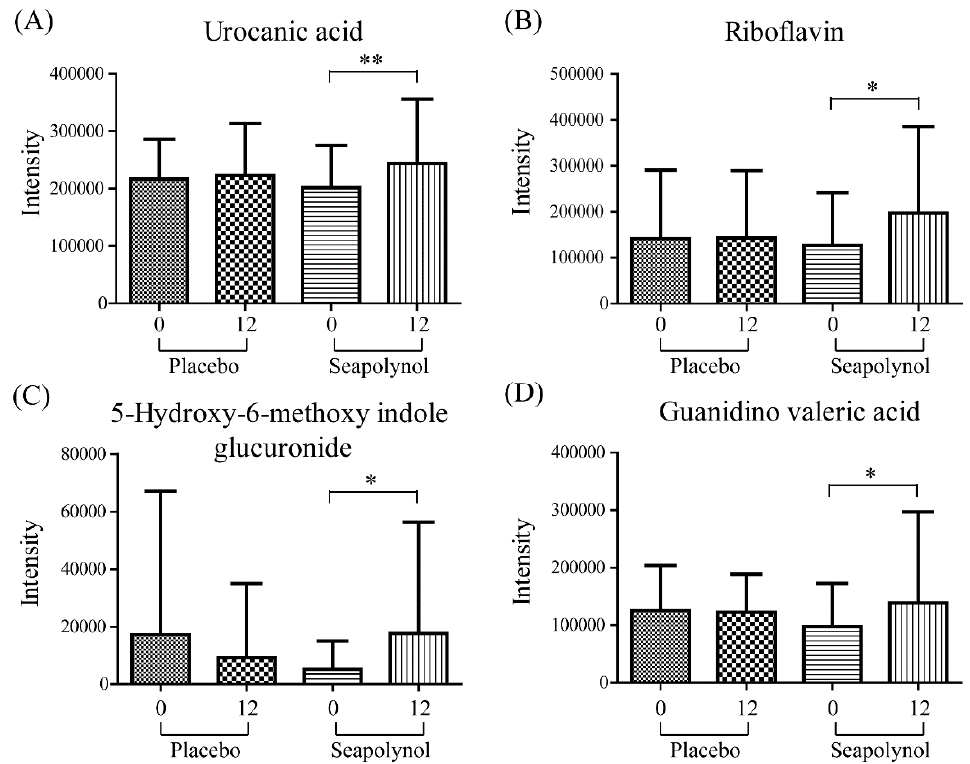
Figure 3. Changes in the levels of the identified metabolites. The levels of ( A ) urocanic acid, ( B ) riboflavin, ( C ) 5-hydroxy-6-methoxyindole glucuronide, and ( D ) guanidino valeric acid were significantly increased over time in the seapolynol group ( p = 0.004, 0.027, 0.039, and 0.025, respectively). Data are presented as means ± standard deviations.